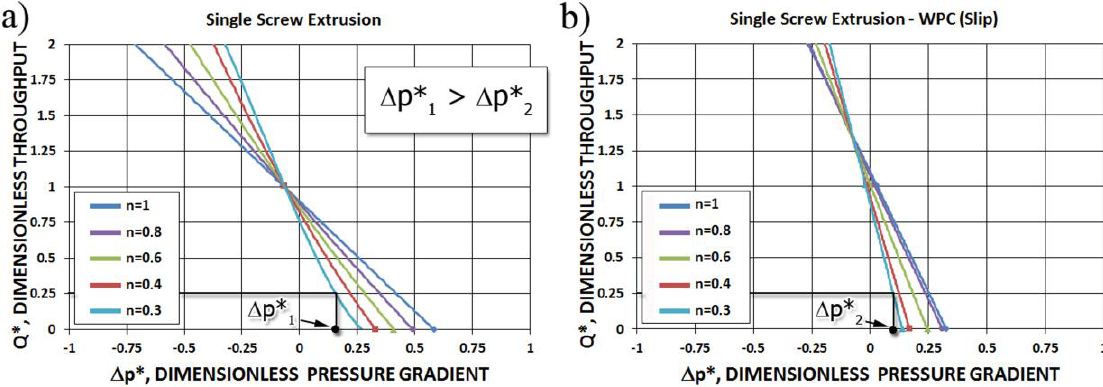
Figure 9. Screw pumping characteristics: ( a ) without slip, ( b ) with slip (see Section 6).